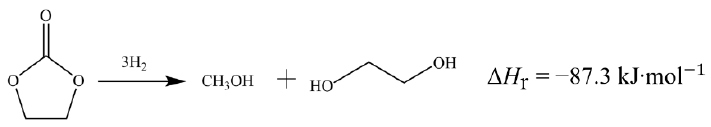
Figure 1. EC hydrogenation reaction.